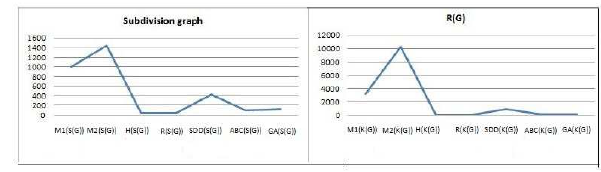
Fig. 11 The comparison between M 1 ( G ) , M 2 ( G ) , H ( G ) , R ( G ) , SDD ( G ) , ABC ( G ) , GA ( G ) indices using S ( G ) and R ( G )